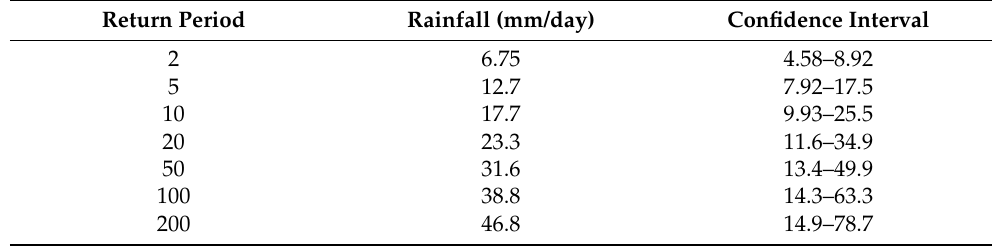
Table 1. Rainfall corresponds to different return periods used in the study to calculate runoff. Return Period Rainfall